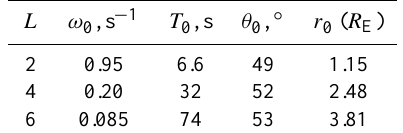
Table 1. List of parameters for L = 2 , 4 , 6 of a standard-dipole field.